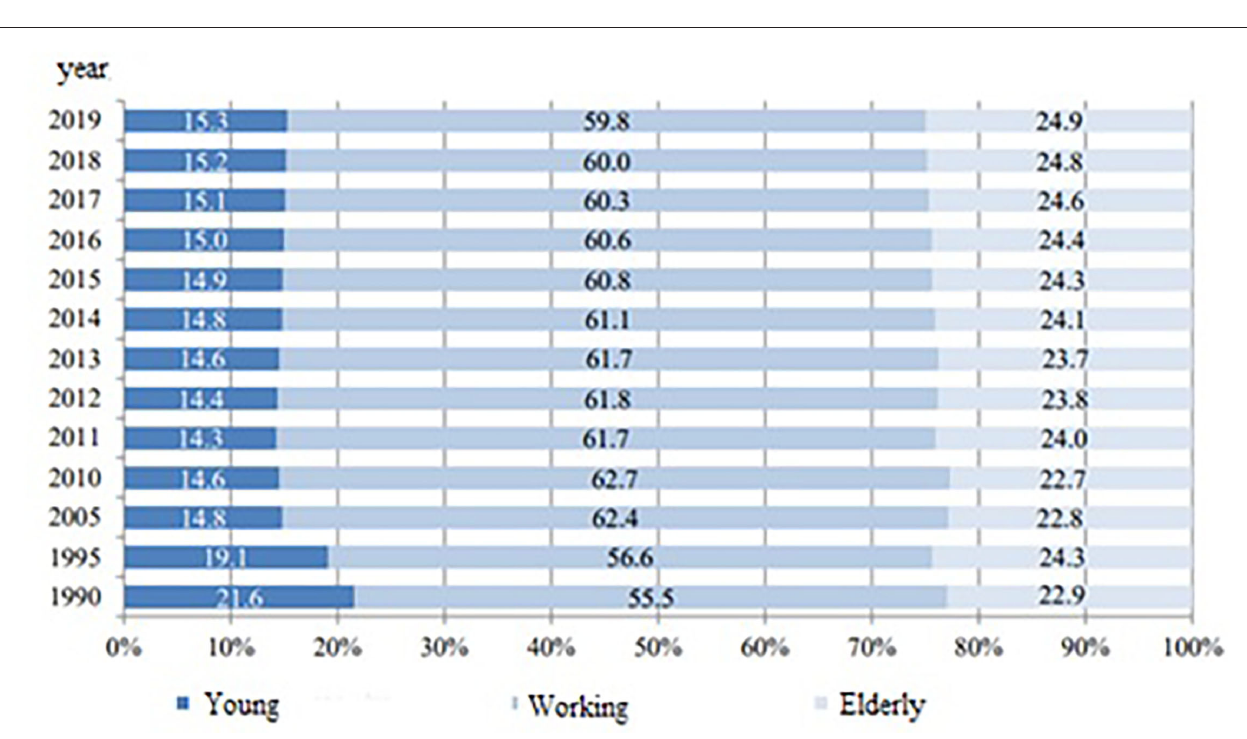
FIGURE 5 | Percentage distribution of the